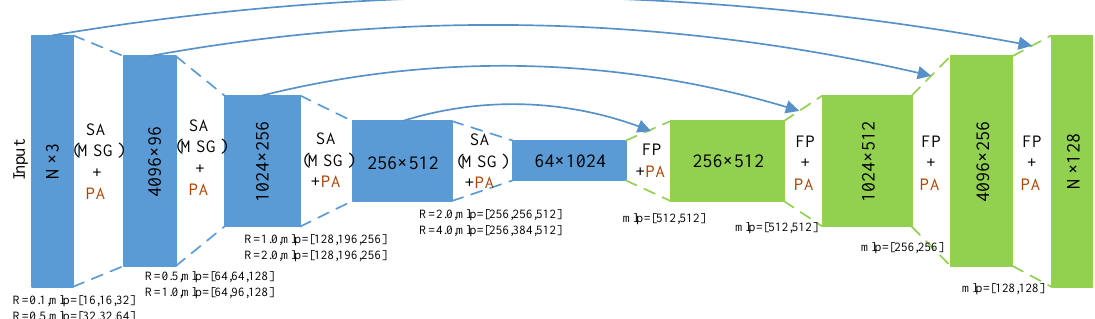
Figure A1. The detailed architecture of our full-point feature extractor based on PointNet ++ (with MSG). The SA is made of Sampling layer, Grouping layer, and PointNet layer. The FP is made of Interpolation layer and Unit PointNet layer. “mlp” refers to the size of the multilayer perceptron, “R” refers to the radius / scale in the Grouping layer.